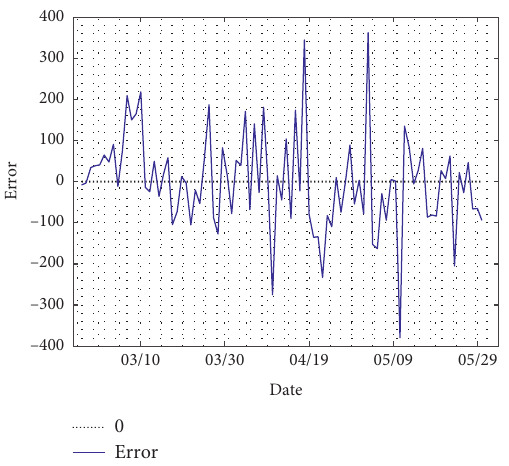
Figure 10: The fitting error of Spain with a mean absolute error of